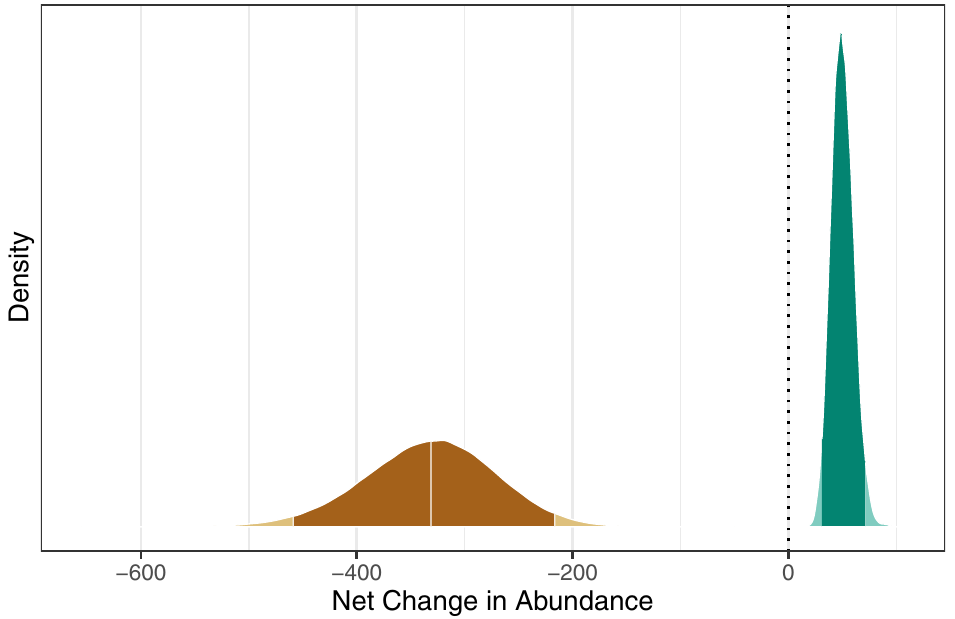
Figure 5. Density plots comparing estimated effect of the year 2013 on abundance (brown) with the net change in abundance in an average year (green). The darker-shaded regions indicate the 95% CRI and the middle vertical break lines within them indicate the median. The dotted line indicates a hypothetical change in abundance of 0